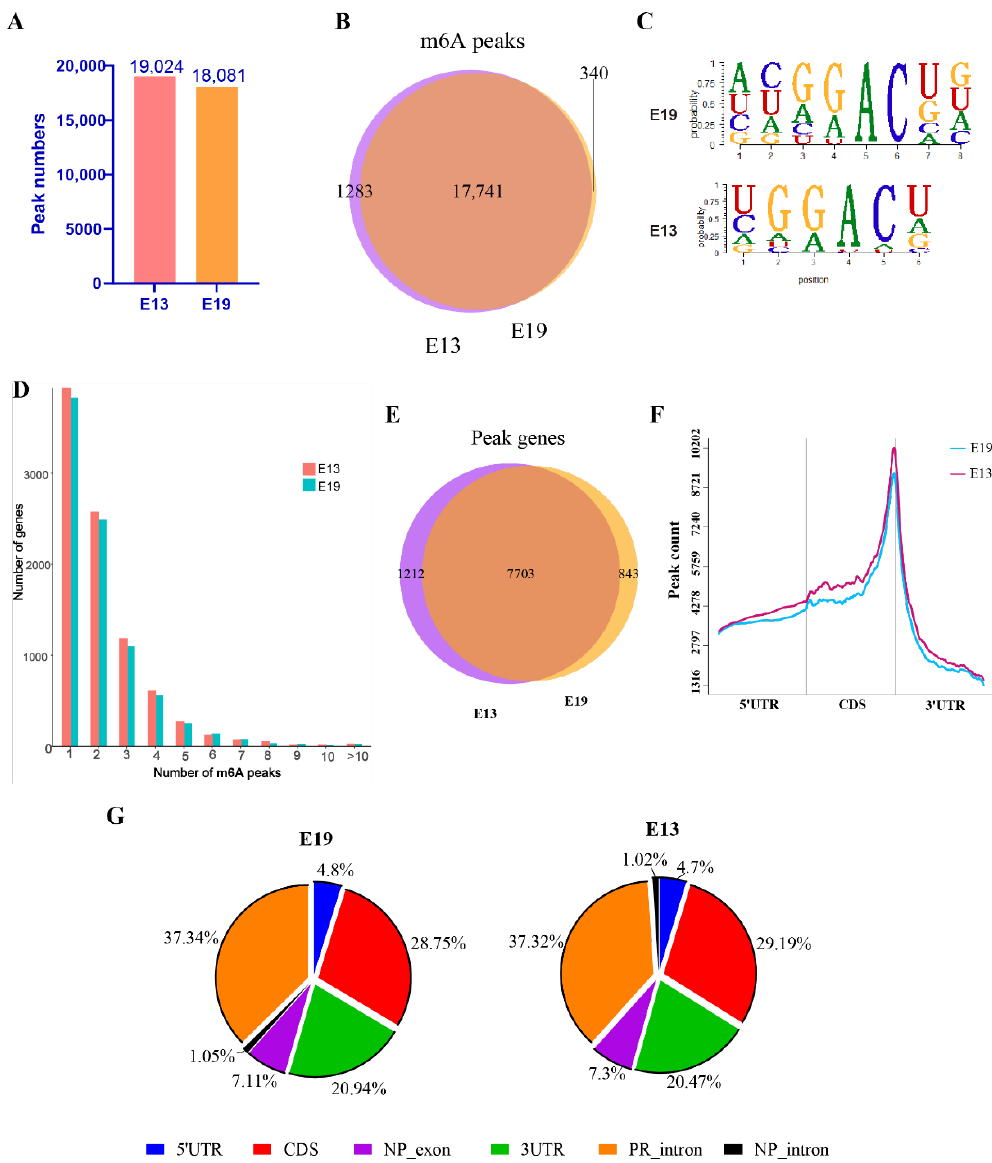
Figure 1. Analysis of transcriptome-wide MeRIP-seq data and m6A peaks. ( A ) Number of m6A peaks in MeRIP-seq data of E13 and E19. ( B ) Venn diagram showing m6A peaks found in E19 and E13. ( C ) Top m6A consensus motifs identified in all m6A peaks. ( D ) Number of m6A peaks in each gene. ( E ) Venn diagram showing the peak genes identified in E19 and E13. ( F ) Abundance of m6A peaks per a mRNA. ( G ) The distribution of m6A peaks on different regions of a gene. NP exon refers to exon on the non-coding gene; PR intron indicates intron on the coding gene; NP intron indicates intron of the non-coding gene.